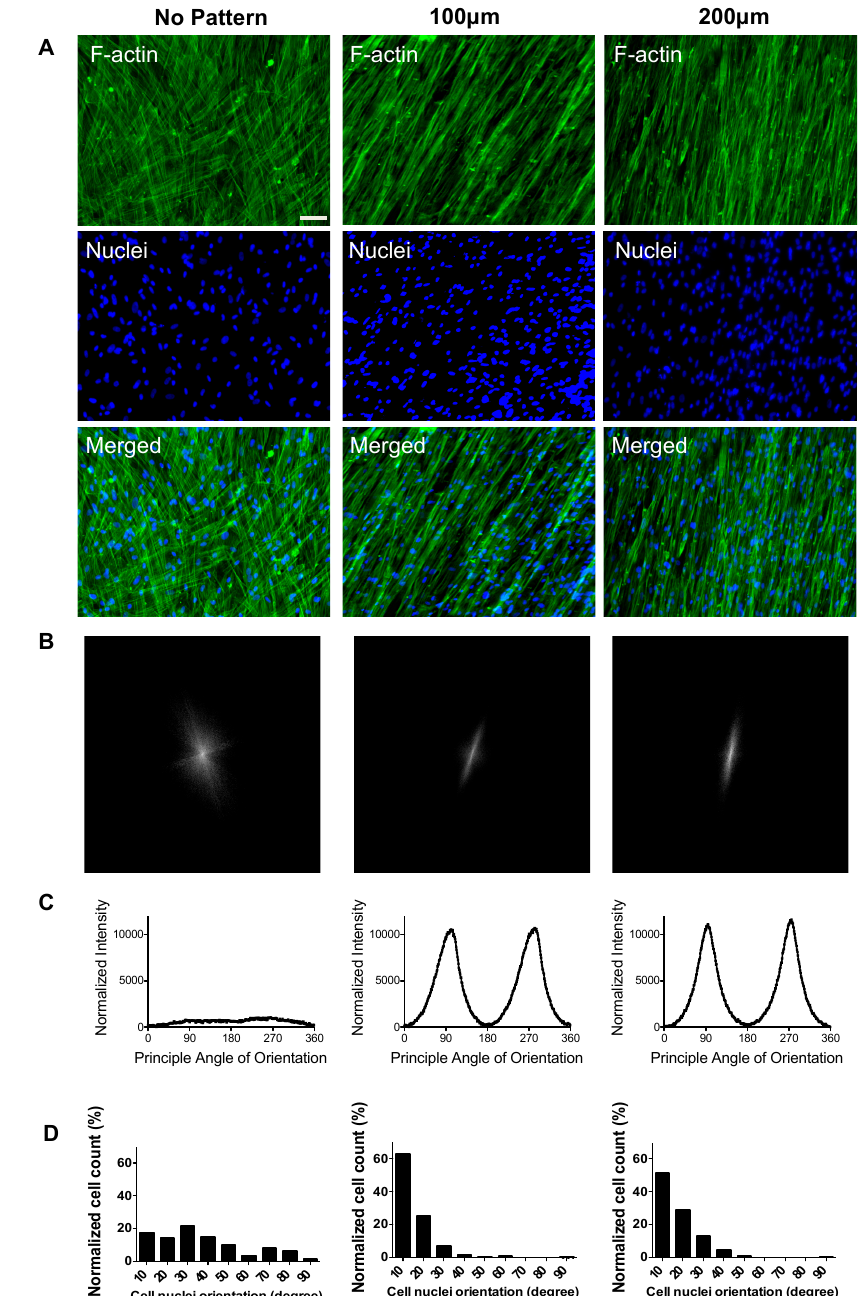
Figure 3. Topological cue-guided cellular alignment of hESC-derived PDGFRA + myogenic progenitor cells. ( A ) F-actin immunofluorescence staining of hESC-derived myogenic progenitor cells cultured on PDMS substrates with various topographical features for 21 days (left column—non-patterned substrate; middle column—micropatterned substrate having 100 μ m grooves; right column—micropatterned substrate having 200 µ m grooves). Scale bar = 100 µ m. ( B ) Frequency domain plots analyzed by the 2D FFT transformation. ( C ) FFT alignment histogram generated by a radial summation of the pixel intensities from 0 to 360 ◦ . ( D ) Cell nuclei orientation of hESC-derived myogenic progenitor cells cultured on PDMS cell culture substrates with various topographical features.